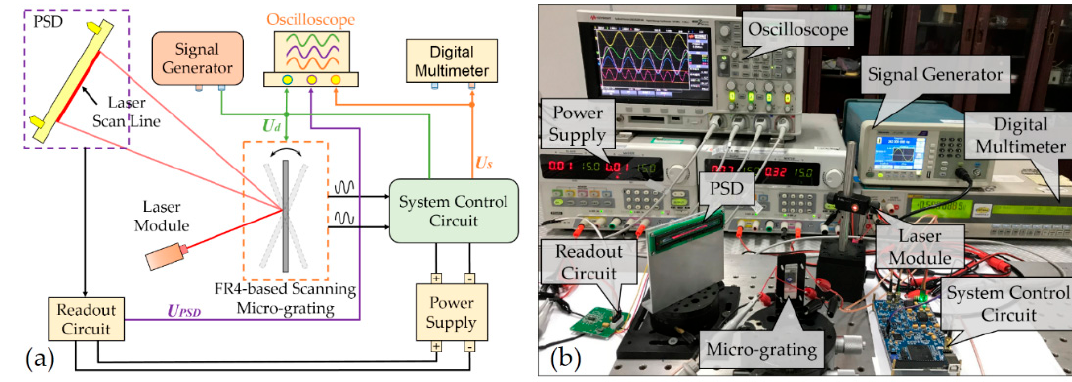
Figure 7. ( a ) Schematic drawing and ( b ) photograph of the measurement setup.